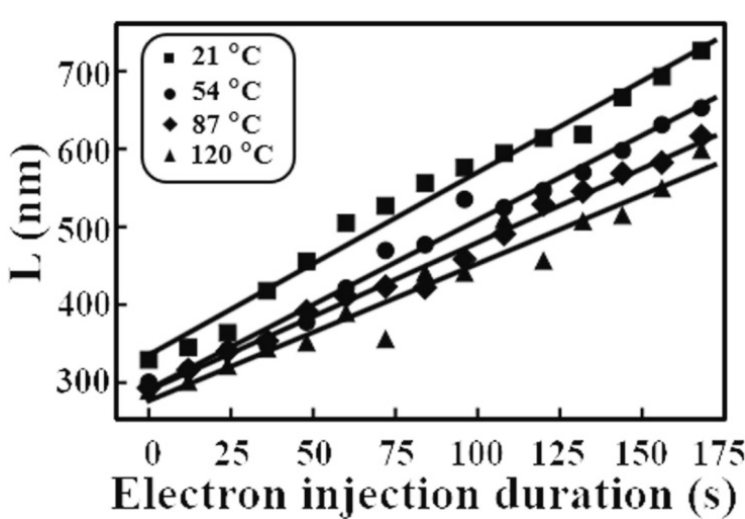
Figure 6. Changes in diffusion length vs. electron injection duration at various temperatures. © The Electrochemical Society. Reprinted/adapted with permission from Ref. [77], 2020, IOP Publishing Ltd.